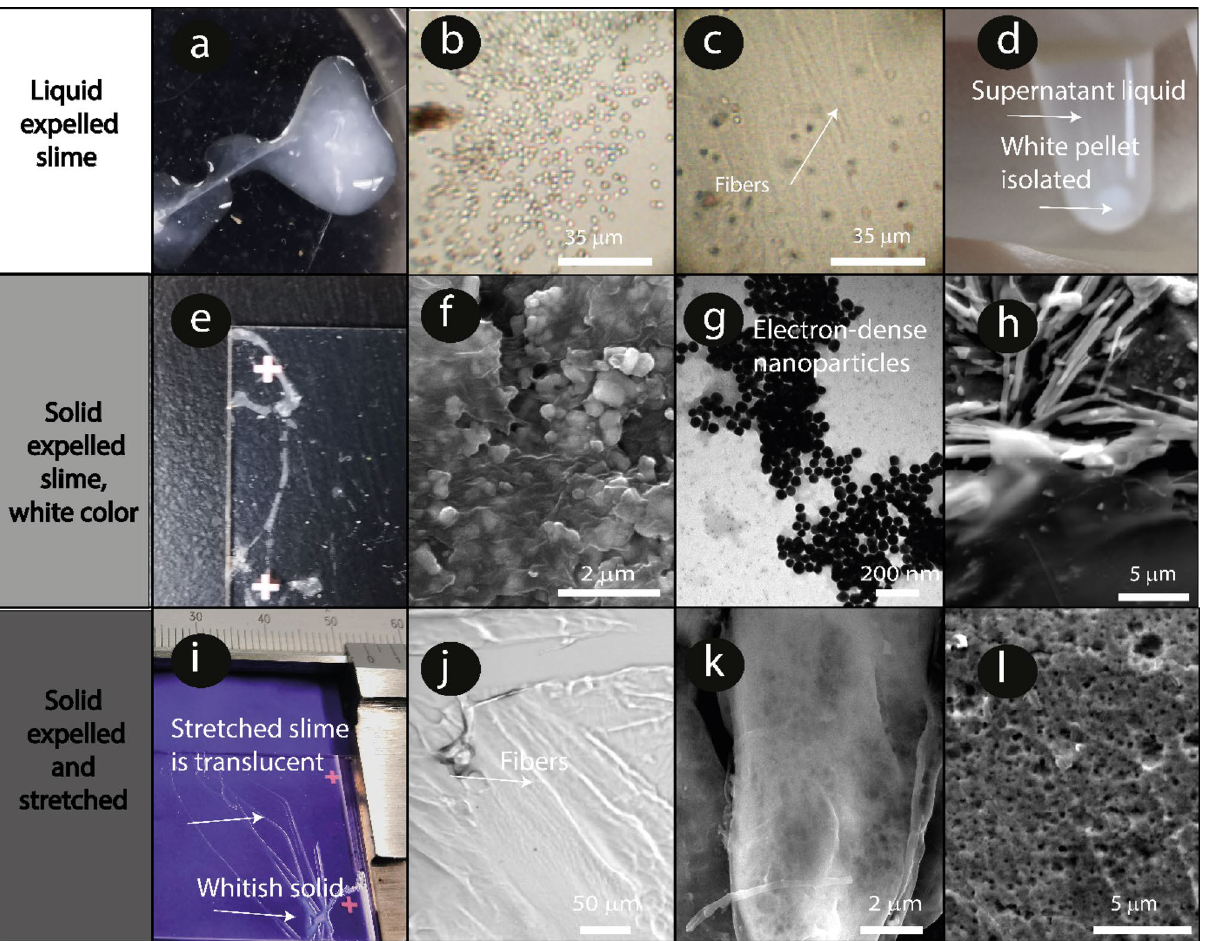
Figure 1. ( a-d ): Liquid expelled slime, ( e–h ): solid expelled slime, ( i-l ) solid expelled slime after a mechanical stimulus (stretching). ( a) Photograph of the white expelled slime on a polystyrene Petri dish. Note that the slime remains liquid without external mechanical stimuli such as stretching. The sample was handled carefully to avoid shear stress. ( b) Bright-field image of the dispersed roundish-microparticles in the liquid protein slime matrix. ( c ) Bright-field image of the fibers and microparticles dispersed in the liquid slime. ( d) White pellet precipitated from the viscous white slime solution. Note that the liquid supernatant is translucent. ( e ) Photograph of the dried expelled slime that did not experience any external mechanical stimulus on a glass slide. Note that this slime remained white. ( f ) SEM micrograph of nano- and microparticles dispersed in the slime. ( g )TEM image of electron-dense roundish nanoparticles < 500 nm size. (h ) SEM image of the fibers and microparticles in the solid expelled slime. ( i ) Expelled slime on a glass slide. Note that the slime in the upper part of the image is translucent (it was stretched) and that the unstretched slime in the lower part remains white. ( j ) Fibers observed in the translucent area ( k ) SEM image of the slime threads formed. Note the absence of nano- and microparticles. ( l ) SEM cross-section image of one slime thread. A porous structure is dorsal area was analyzed and compared with the slime. Therefore, the presence of cells in the expelled slime was also investigated.